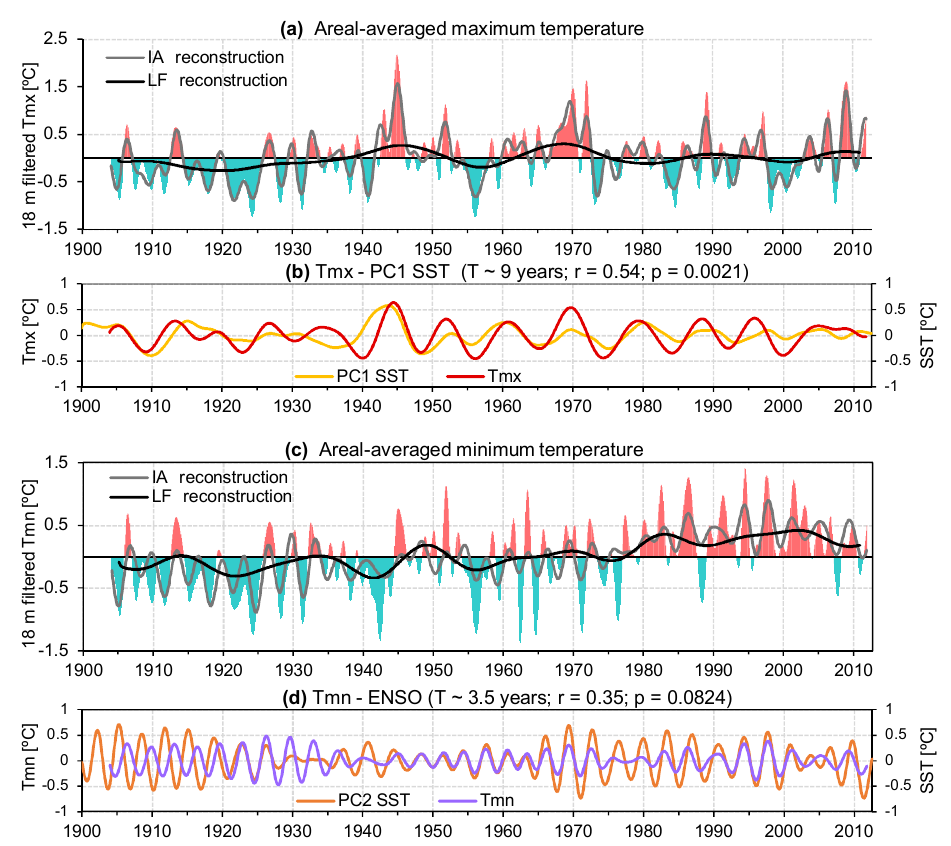
Figure 5. Panels (a) and (c) present the 18m low-pass-filtered monthly time series of areal-averaged daily maximum and minimum temper- ature anomalies (in shades) and their partial reconstructions (in lines) using all interannual and low-frequency variability modes described in Table 2. Panels (b) and (d) depict the temporal evolution of the dominant modes of regional temperature and the first two leading patterns of global SST variability. T denotes the dominant period of the leading modes, and r indicates the Pearson correlation coefficients between time series. Significance levels ( p values) for r are estimated by combining 2000 Monte Carlo iterations considering autocorrelation by resampling in the frequency domain (Macias-Fauria et al.,